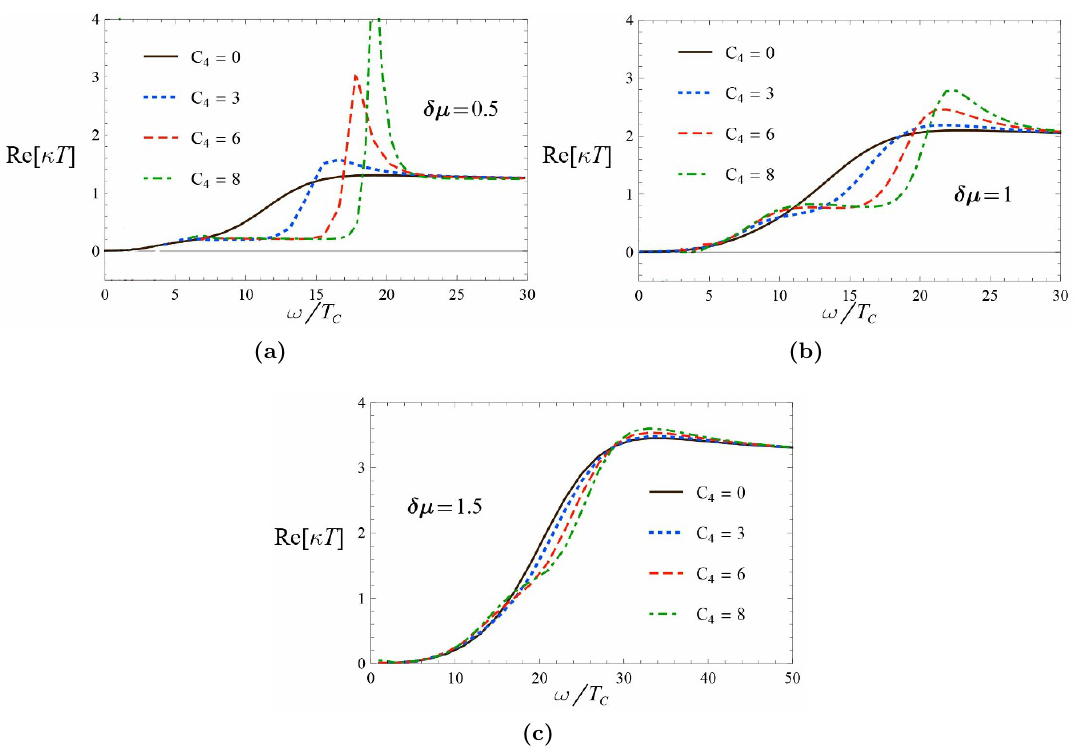
Figure 16. The real part of the thermal conductivity in terms of !=T c for function F ( ) = 2 + C 4 with C 4 4 = 0 ; 3 ; 6 ; 8 (solid curve, dotted curve, dashed curve, and dot-dashed curve)